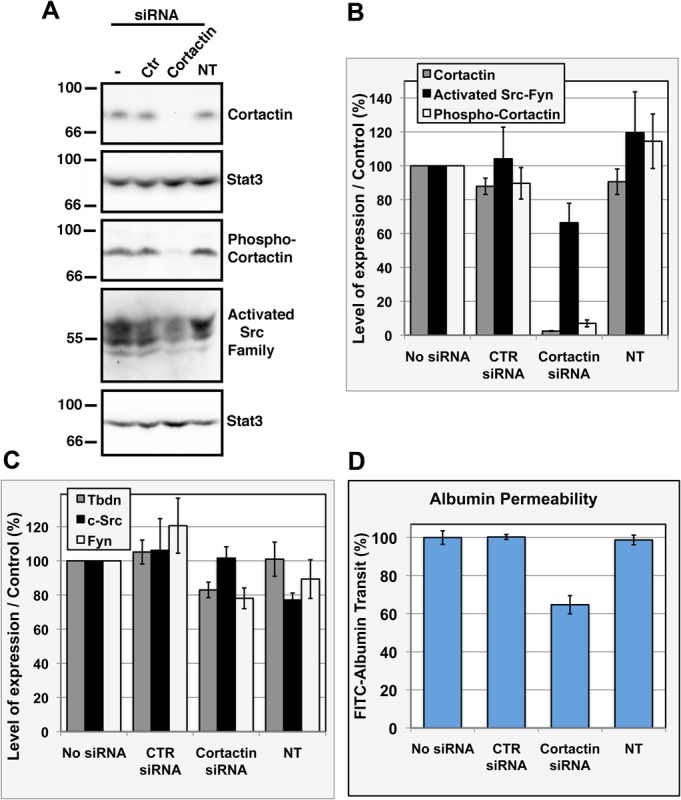
Role of Cortactin in the regulation of Src family of kinases and Albumin permeability in retinal endothelial cells knocked down for Tbdn. Cortactin expression was knocked down by transfection of Cortactin siRNA (Cortactin siRNA) compared to control siRNA (CTR siRNA), no siRNA (No siRNA) and non-transfected (NT) RF/6A retinal endothelial cells knockdown for Tbdn. Samples were analyzed by western blotting for levels of Cortactin, activated SFK (Activated Src Family), phospho-Cortactin (Tyr421), total c-Src (Src), total Fyn, Tbdn, and Stat3 or Tubulin for loading control; and Albumin permeability assay. (A) Representative western blot analysis is shown. (B,C) Quantitation of western blot analyses of indicated protein over loading control (Tubulin or Stat3). Relative to cells transfected with control siRNA (CTR siRNA) or no siRNA (No siRNA) and non-transfected (NT) cells, Cortactin siRNA transfected cells exhibited reduced levels of Cortactin (P<0.0001), reduced levels of activated Src-Fyn (P≤0.049), and reduced levels of phospho-Cortactin (P<0.009) (B), while Tbdn, total c-Src and total Fyn were not significantly changed (C). (D) The transit of FITC-Albumin across Cortactin siRNA transfected retinal endothelial cells knockdown for Tbdn (Cortactin siRNA) was reduced compared to controls (CTR siRNA, No siRNA and NT) (P<0.0001). B-D: Results are expressed as percentage relative to control cells transfected without siRNA and represent the means±s.e.m. of at least 3 experiments.